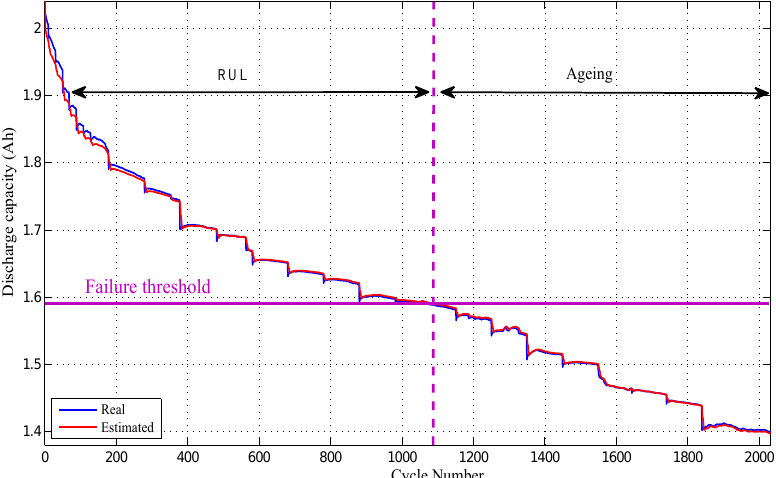
Figure 12. Evolution of the discharge capacities with respect to cycling number.